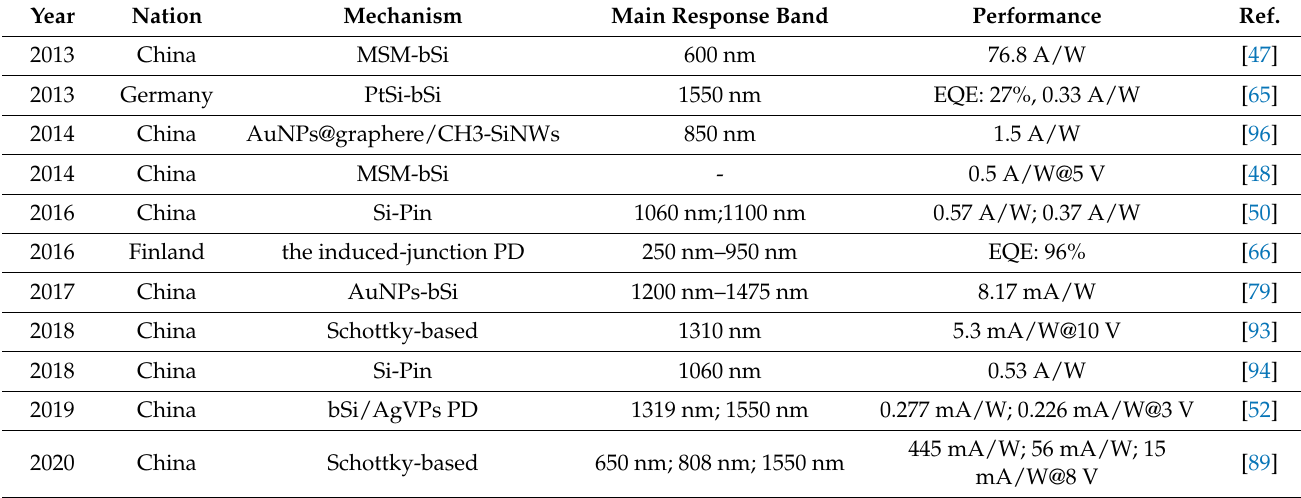
Table 1. Performance comparison of photodetectors based on black